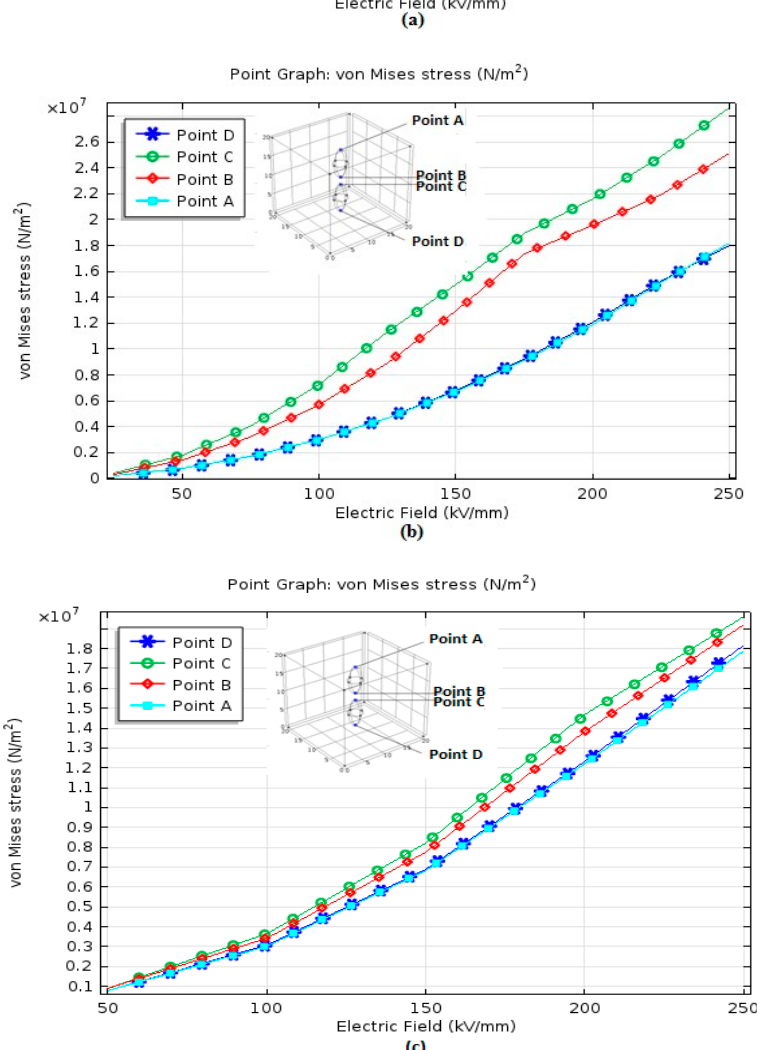
Figure 17. Von Mises stress at the tips of ellipsoids with an increase in the electric field (50–250 kV/mm) and decreasing distance between points B and C: ( a ) distance: 0.5 µm; ( b ) distance: 1 µm; ( c ) distance: 2 µm.